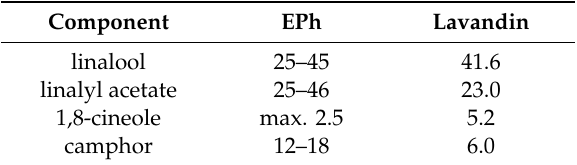
Table 2. Percentage of the main compounds in the LEO sample in comparison with the accepted percentages by European Pharmacopoeia